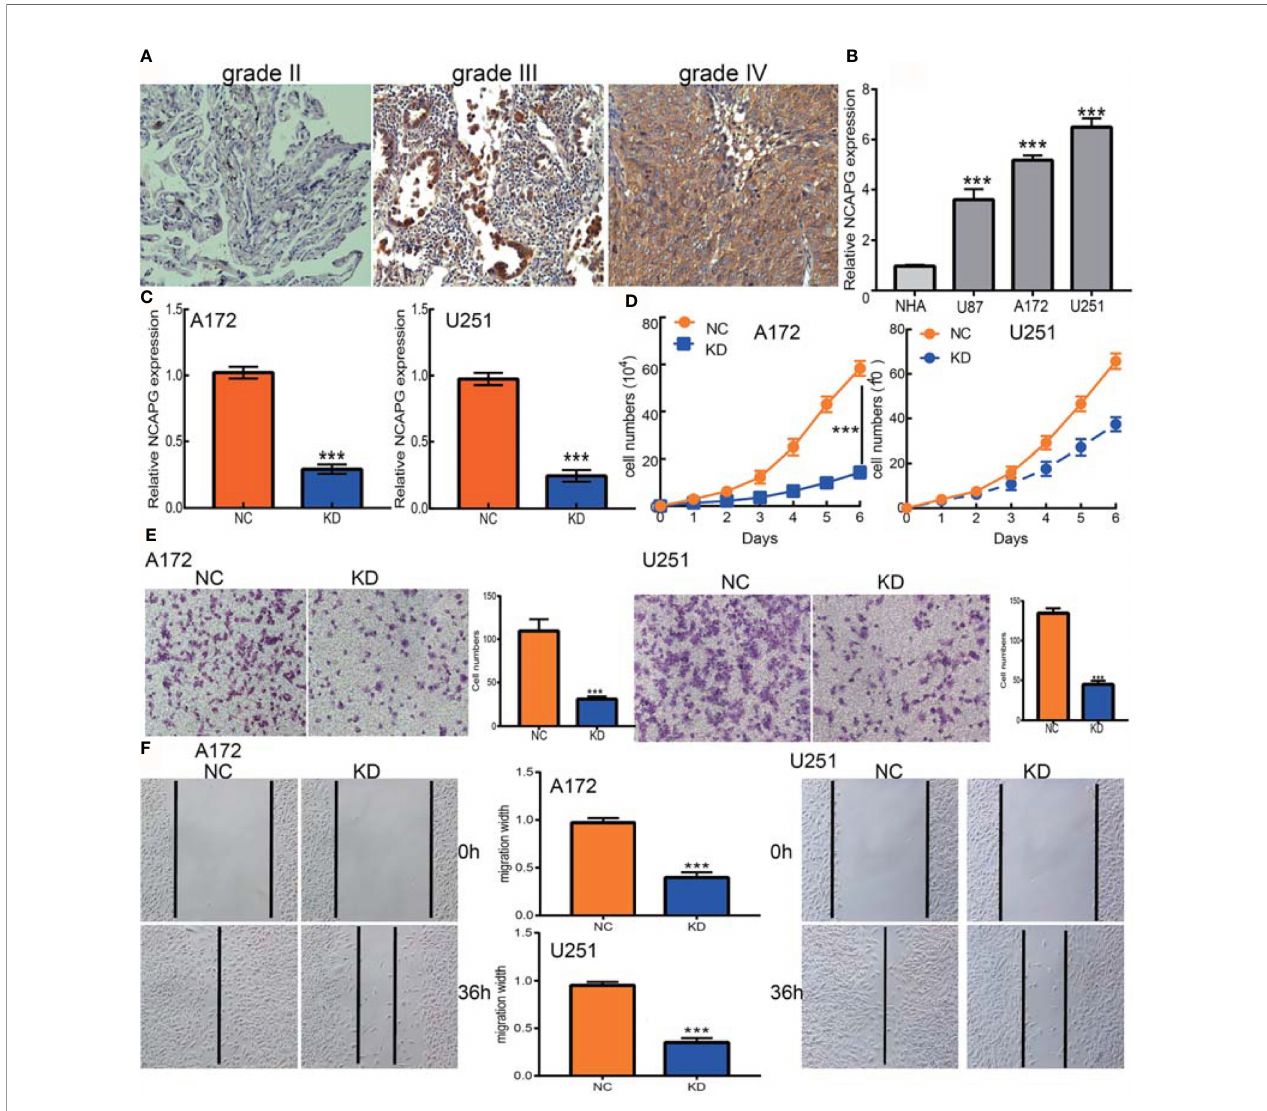
FIGURE 9 | NCAPG depletion inhibits GBM cell proliferation and migration. (A) Immunohistochemistry detection of NCAPG in normal brain tissue, glioma, and HGG. (B) The expression of NCAPG in normal human astrocytes cells (NHA) and GBM cell lines (U87, A172, and U251). (C) The NCAPG knockdown ef fi ciency in A172 and U251 cells veri fi ed by qRT-PCR assay. (D) NCAPG knockdown signi fi cantly inhibited A172 and U251 cell proliferation examined by growth curve assay. (E, F) NCAPG knockdown signi fi cantly inhibited A172 and U251 cell migration as examined by transwell and wound healing assays. Scale bar =50 m m. NC=Negative control, KD=NCAPG Knockdown, *** P